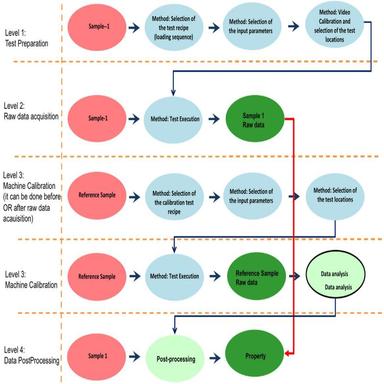
CHADA workflow for nanoindentation.